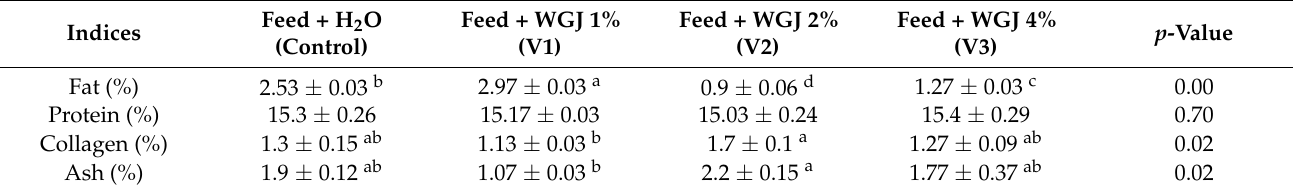
Table 5. Body composition of common carp feed experimental diets with different inclusion levels of wheat grass juice (WGJ).